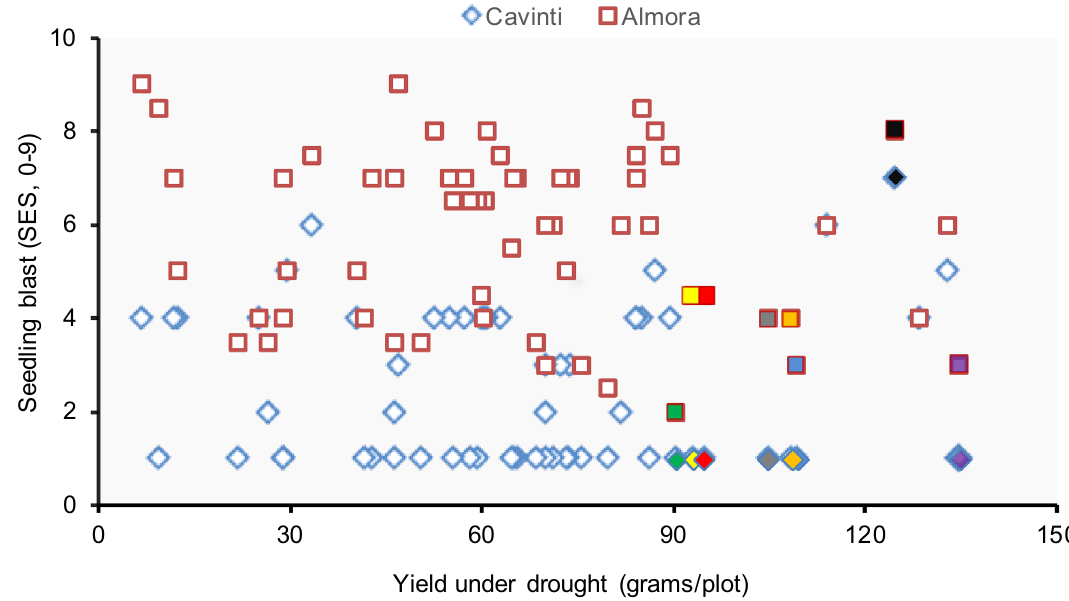
Figure 6. Yield during DS drought conditions at IRRI against seedling blast infection recorded at Cavinti and Almora of selected 60 F 5 progenies from intermated BC 3 F 4 lines. Highlighted in the graphic, filled data points correspond to lines (from left to right): IR78221-19-6-7-B-B (green); IR78221-19-6-3-B-B (yellow); IR78221- 19-6-33-B-B (red); IR78222-20-7-128-B-B (gray); IR78221-19-6-90-B-B (orange); IR78221-19-6-99-B-B (blue); IR78221-19-6-56-B-B (purple); black